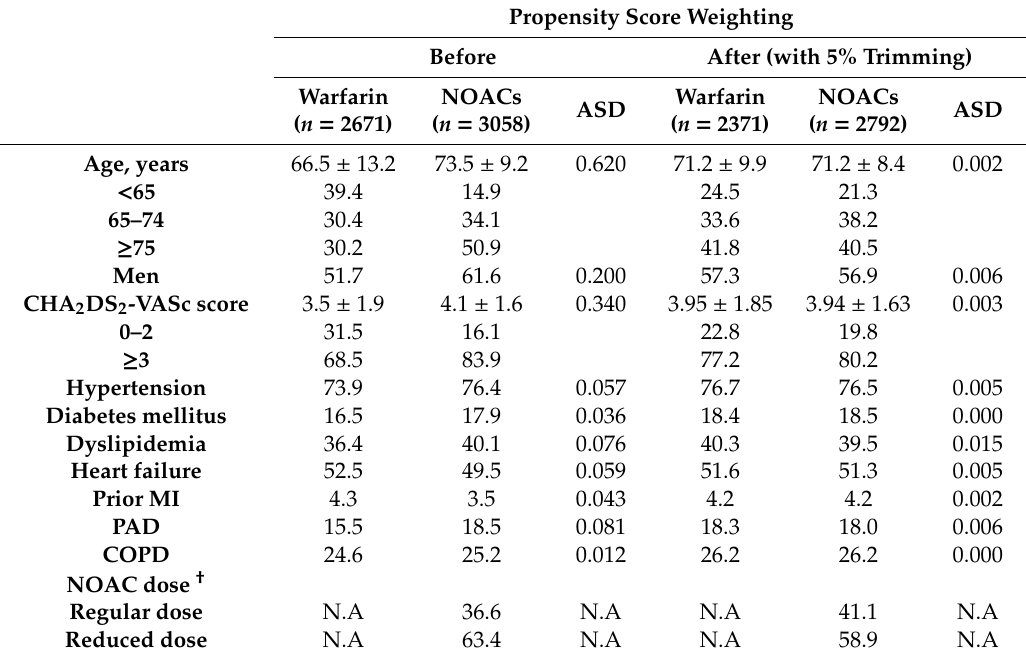
Table 1. Baseline characteristics of patients with EHRA type 2 VHDs between warfarin versus NOACs.